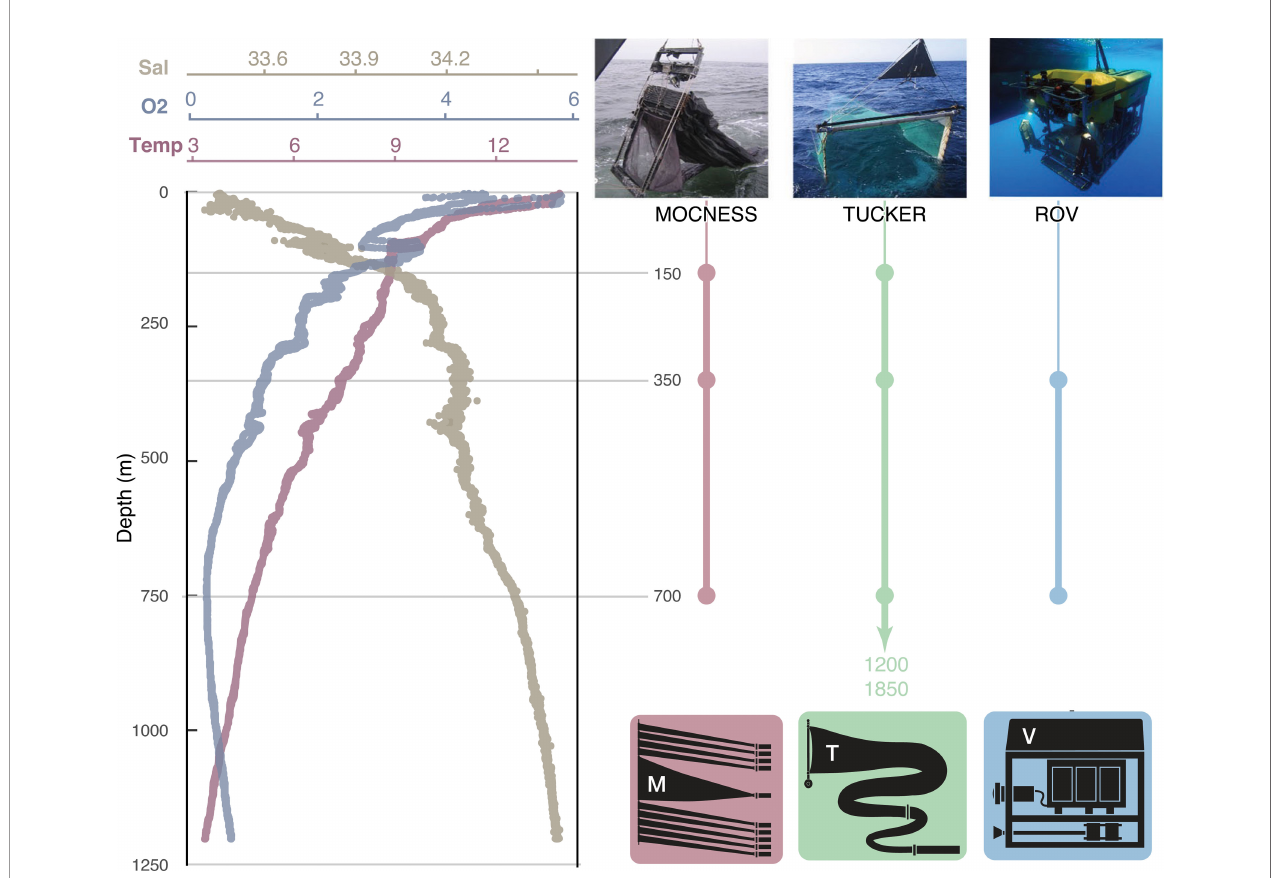
FIGURE 1 | Hydrographic variables (salinity, oxygen, and temperature) in Monterey Bay collected from a CTD deployment where trawl and ROV surveys were conducted. Three sampling approaches were used for the collection of zooplankton communities (from left to right): Multiple Opening and Closing Net with Environmental Sensing System (MOCNESS) (photo credit: SHD Haddock), Tucker trawl (photo credit: SHD Haddock), and a remotely operated vehicle (ROV) equipped with high-de fi nition cameras to record video observations of organisms (photo credit: Monterey Bay Aquarium Research Institute). Three sampling depths were targeted in the epi- and mesopelagic. Not pictured are two additional Tucker trawl sampling depths in the bathypelagic (1200 and 1850 m). See Table 1 for precise depth ranges for each trawl.